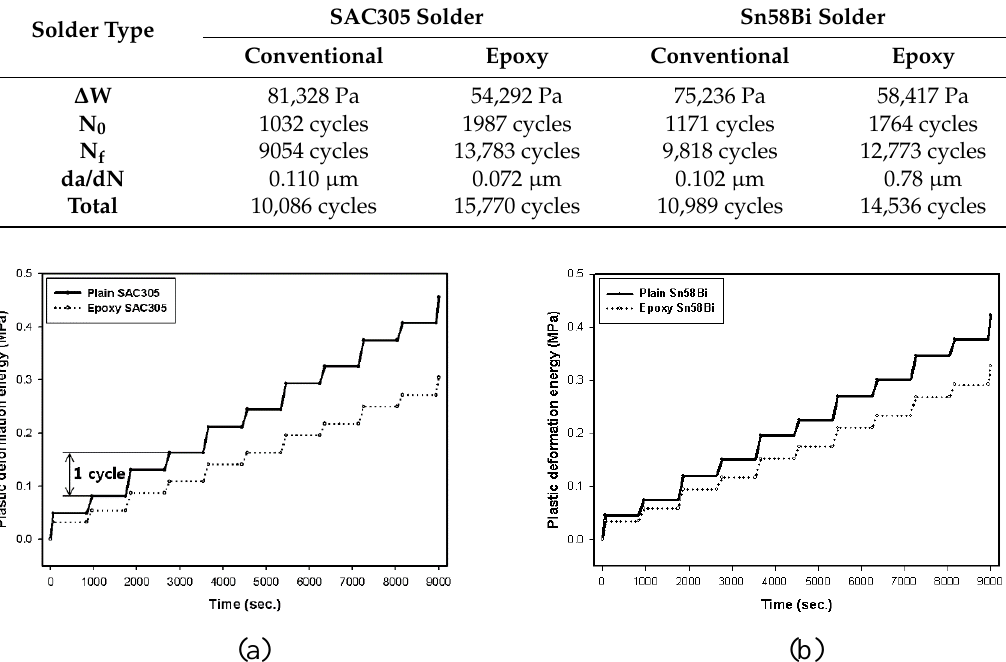
Table 3. Lifetime predictions for SAC305 and Sn58Bi solder joints with or without epoxy.